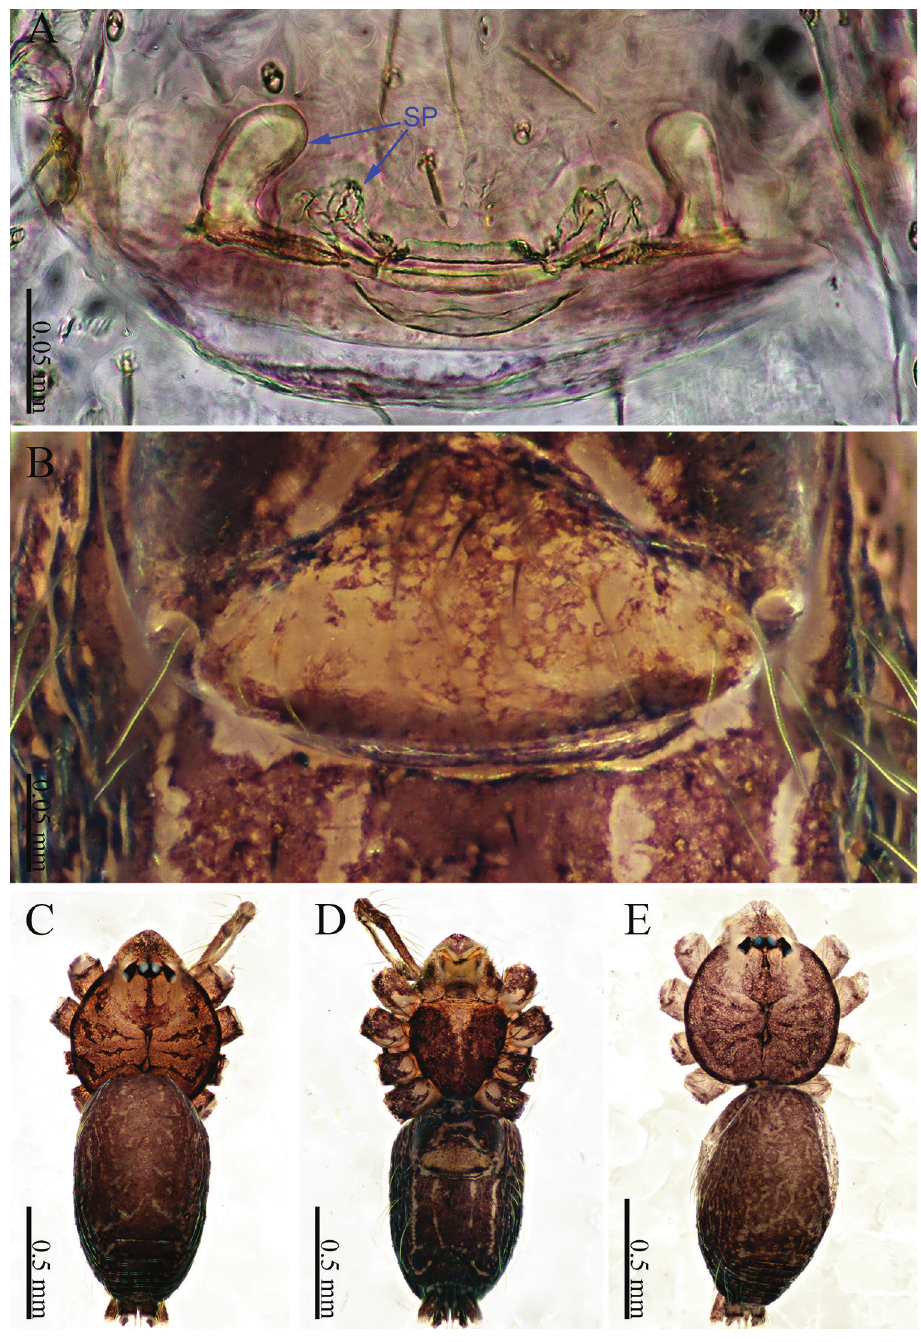
Figure 14. Sinoderces wenshanensis Li & Li, sp. nov., male holotype and female paratype A internal geni- talia, dorsal view B female epigastric furrow, ventral view C female habitus, dorsal view D female habitus, ventral view E male habitus, dorsal view. Abbreviation: SP